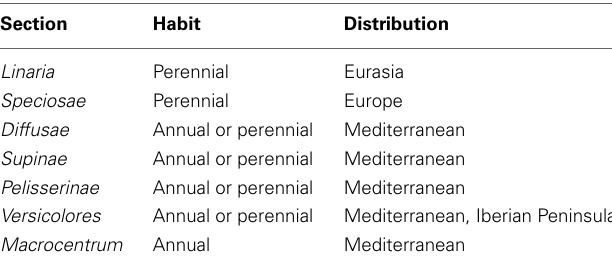
Table 2 | Major features of infrageneric taxa of the genus Linaria (according to Sutton,